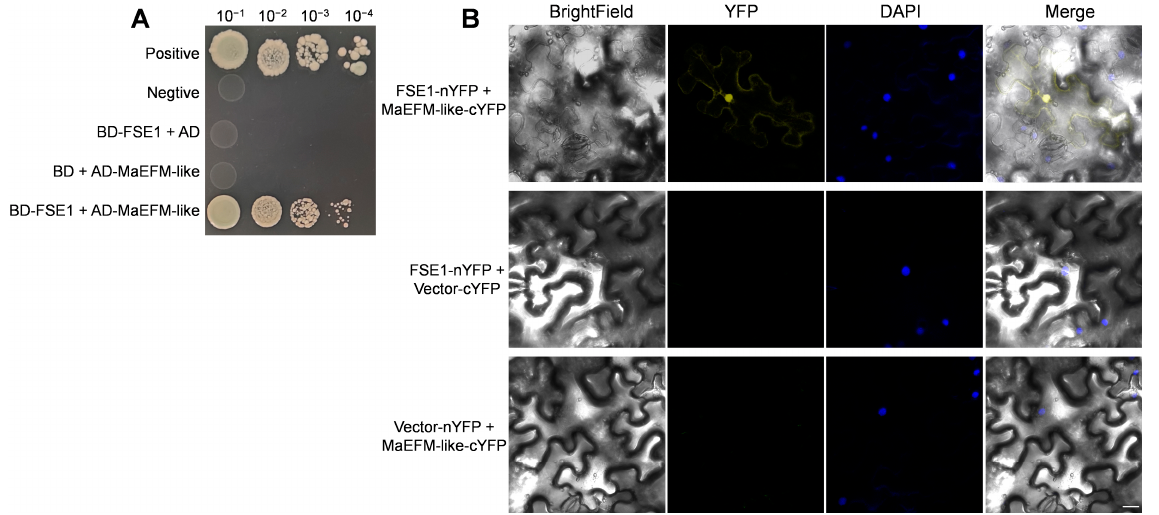
Figure 7. MaEFM-like induced cell death in tobacco leaves and FSE1 suppressed the cell death in- duced by MaEFM-like. ( A ) Leaves expressing empty vector, FSE1 , or MaEFM -like were photo- Figure 6. Verifying interaction between FSE1 and MaEFM-like. ( A ) Yeast two-hybrid (Y2H) assays graphed under normal light ( up ) and UV illumination ( bottom ). ( B ) FSE1 suppressed the cell death showing FSE1 interact with MaEFM-like. Yeast cell were grown on SD/-Trp-Leu-His-Ade plates induced by MaEFM-like. ( C ) Statistical analysis of necrotic area in tobacco leaves. Data are shown containing 125 ng mL − 1 aureobasidin A (ABA). ( B ) BiFC analysis of in planta interaction between as the means ± SD, and columns with different letters indicate significant difference ( p < 0.05). FSE1 and MaEFM-like in N. benthamiana epidermal cells. DAPI, 4 (cid:48) ,6-diamidino-2-phenylindole. Scale Bar = 25 µ m.